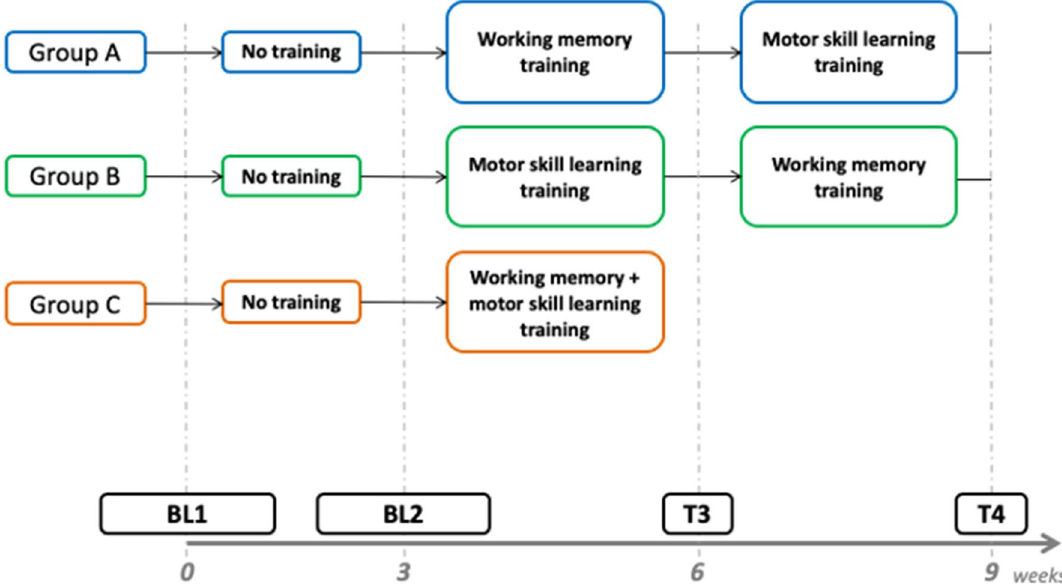
Figure 1. Study procedures. Each assessment (BL 1, BL2, T3 and T4) included an MRI and cognitive